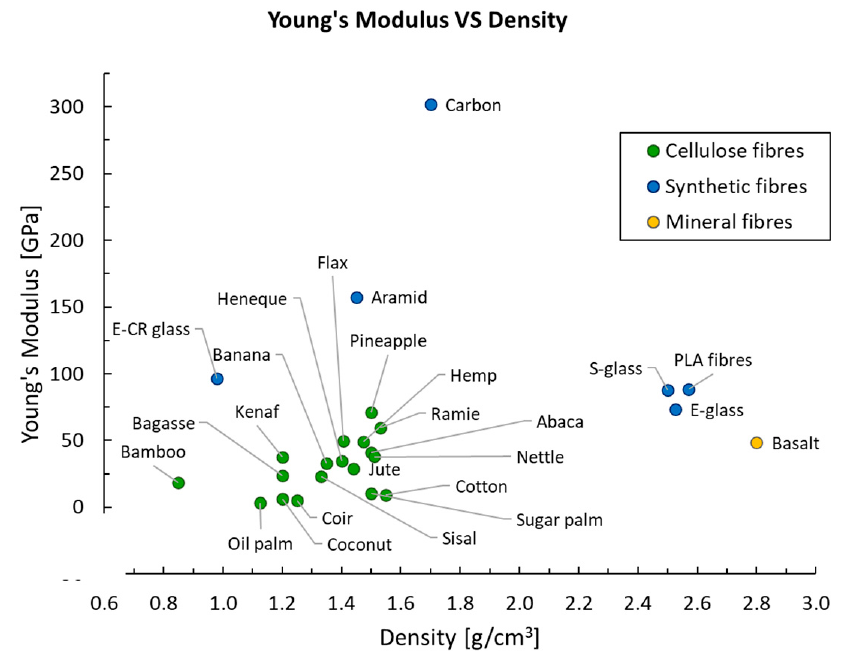
Figure 7. Map of the Young’s modulus against density for several cellulose, synthetic, and mineral fibres. Data from [52, 55, 58-63].